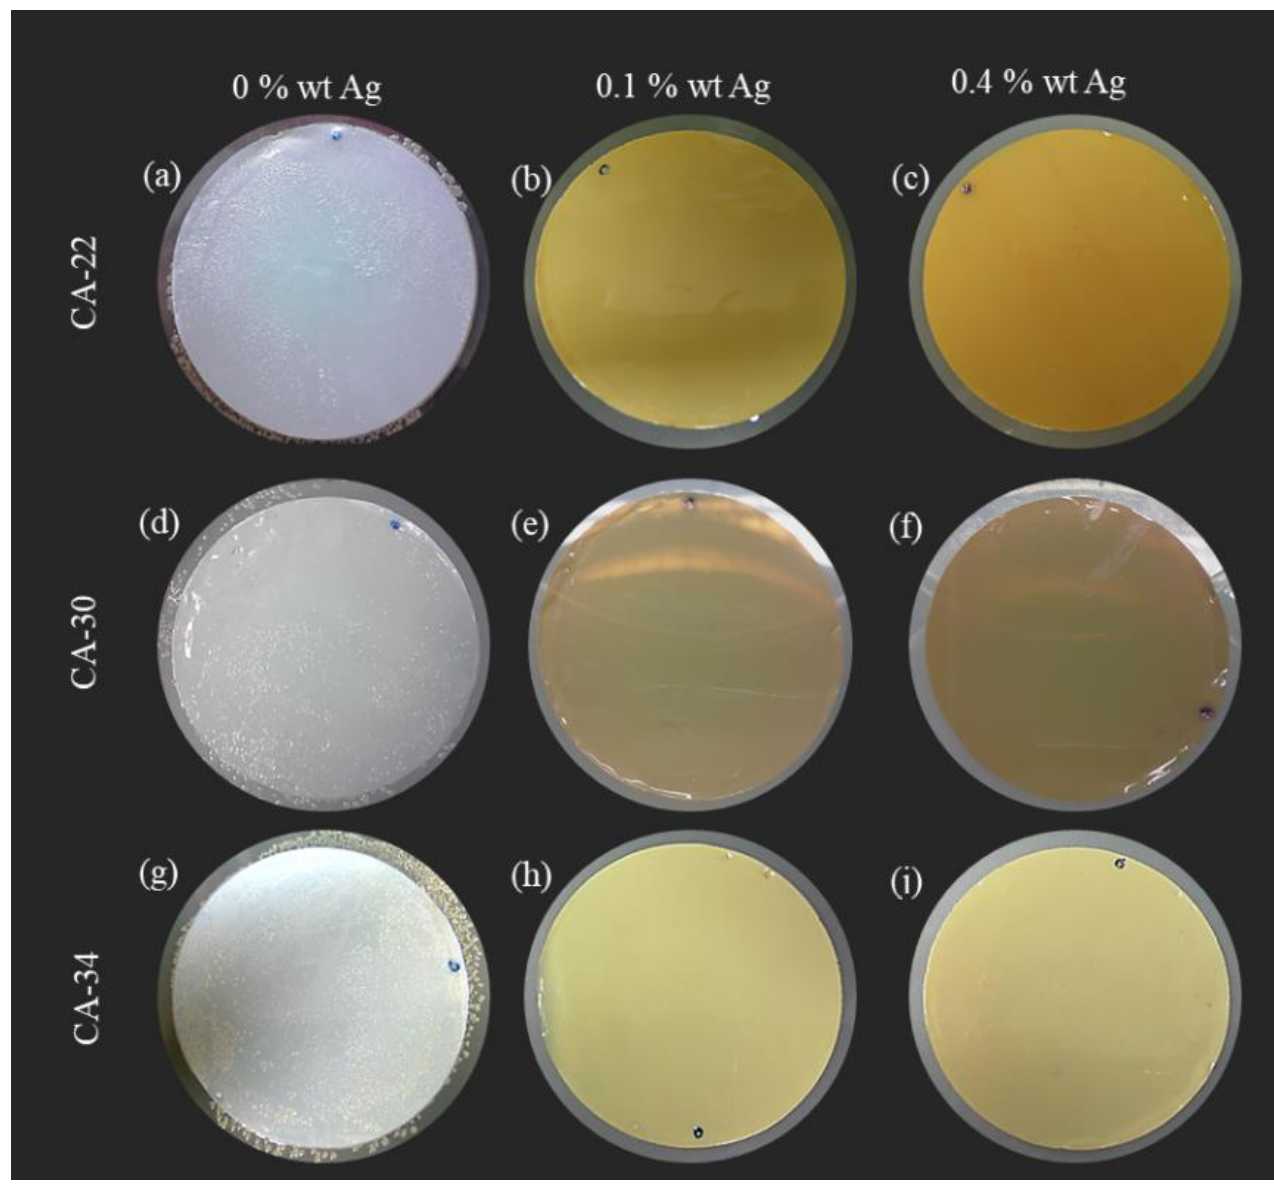
Figure 12. Results of E. coli growth inhibition on the membrane for the suspension test of CA membranes ( a ) CA22, ( d ) CA30, and ( g ) CA34; CA/Ag membranes with 0.1%wt Ag ( b ) CA22Ag0.1, ( e ) CA30Ag0.1, and ( h ) CA34Ag0.1; and CA/Ag membranes with 0.4%wt Ag ( c ) CA22Ag0.4, ( f ) CA30Ag0.4, and ( i ) CA34Ag0.4.